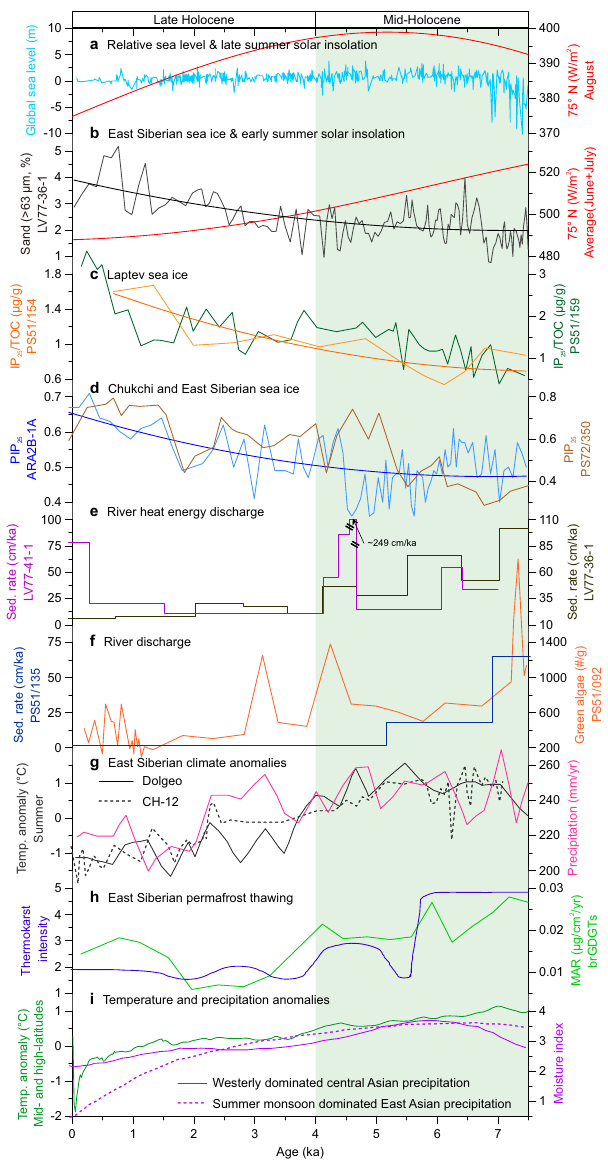
Fig. 2 | Proxy records for the Arctic sea ice and pan-Arctic river environment duringtheHolocene.a Globalsealevel 36 andsolarinsolationinlatesummerat75° N 51 . b – d Solar insolation in early summer at 75°N 51 and reconstructions of sea ice changeintheEastSiberianSea(thisstudy),theLaptevSea 18 ,andtheChukchiSea 10 . The smooth lines represent the binomial expression of the data to obtain the Holocene orbital tendency. Reconstructions of Russian pan-Arctic river heat dis- chargein e theEastSiberianSea(thisstudy)and f theLaptevSea 49,63 . g Pollen-based reconstructions for the Russian Arctic temperature and precipitation in the sum- mer season from the Dolgeo (solid black line) 22 and CH-12 (dotted black line) stations 20 . h Reconstruction of Siberian permafrost thawing 45,46 . i Summaries of air temperatureinmid-andhigh-latituderegions 21 andthewesterlydominatedcentral (solid purple line) and summer monsoon dominated eastern Asian (dotted purple line) moisture in summer 19 based on hundreds of sedimentary records. The green bandrepresentsthemid-Holoceneduring7.5 – 4.0ka.Sed.Rate,MAR,andbrGDGTs indicate the sedimentation rate, mass accumulation rate, and branched glycerol dialkyl glycerol tetraethers, respectively. See the reconstruction for the past 9000 years in Supplementary Fig.